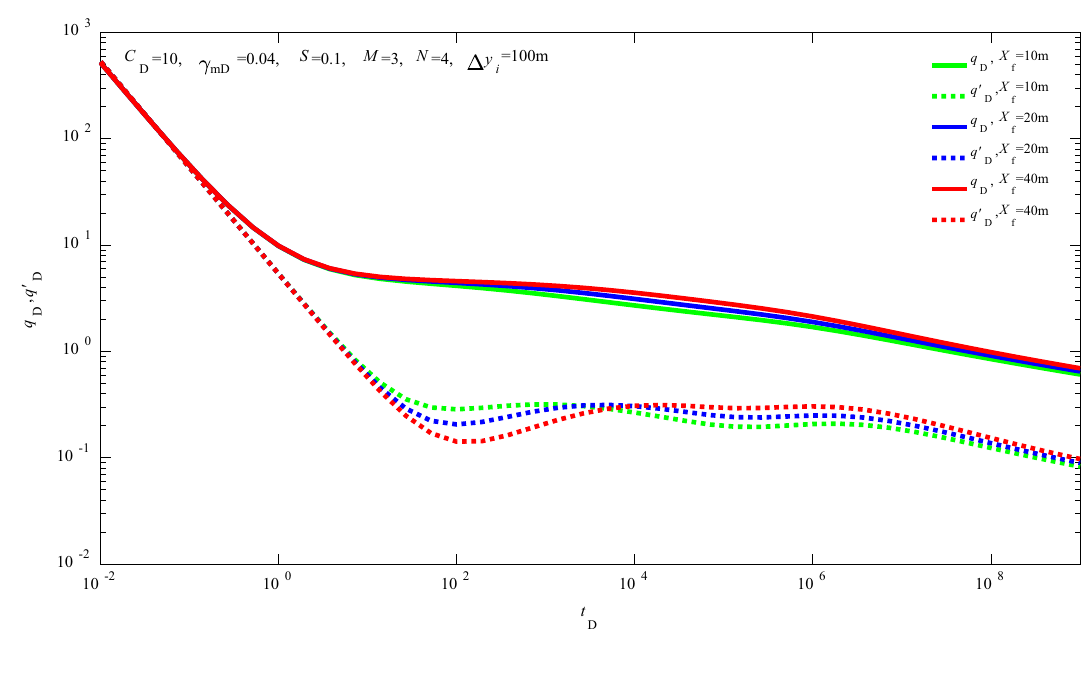
Fig. 11 Effect of fracture half-length on rate decline